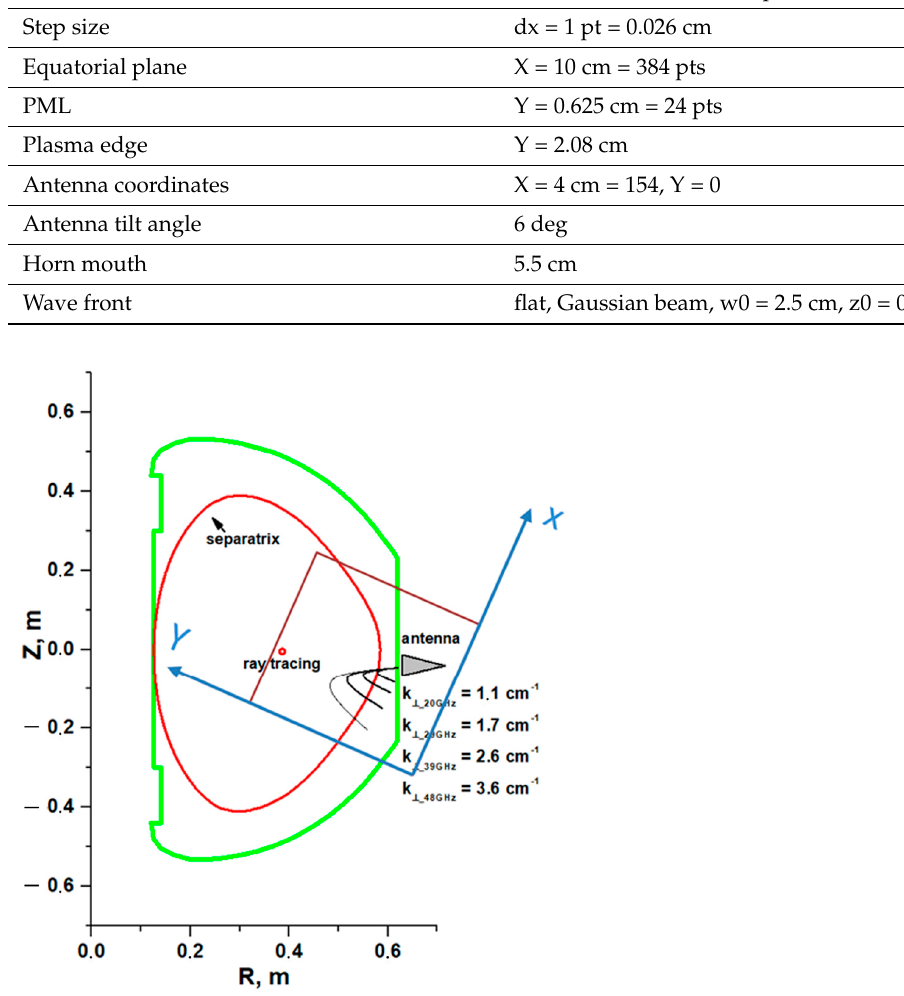
Figure 2. Poloidal cross-section of the Globus-M2 tokamak with performed ray tracing. Computations were performed for a range of probing frequencies, i.e., 20, 29, 39, 48, 50, 55, 60, 65, 70, and 75 GHz, in O-mode, which corresponded to the one in the installed systems in the Globus-M2 tokamak. Their schematics are presented in Figure 3. The system on the left is the low-frequency system, which uses homodyne detection, and the one on the right is the high-frequency system that employs heterodyne detection. The systems are described in detail in the works in